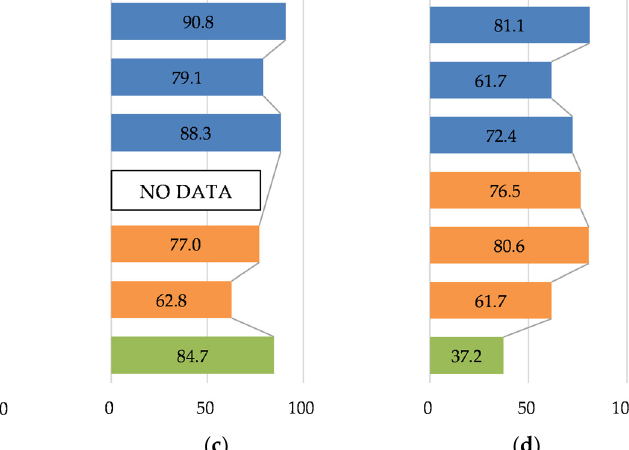
( b ) class A, ( c ) class B, and ( d ) class C.